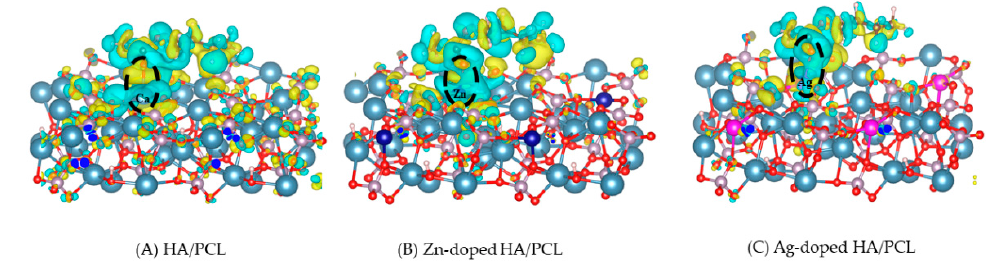
Figure 5. Charge-density difference of PCL on different HA surfaces.